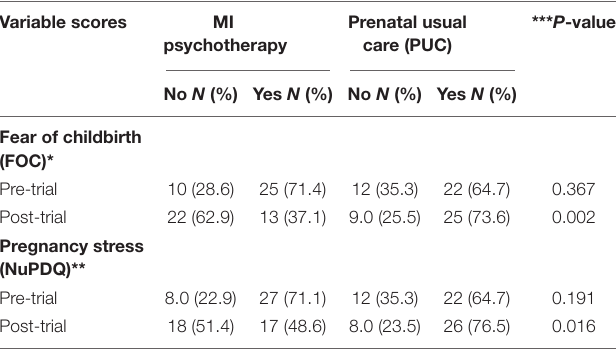
TABLE 4 | Clinical changes in scores of fear of childbirth and pregnancy stress in two groups of participants from pre-trial to post-trial. Variable scores MI